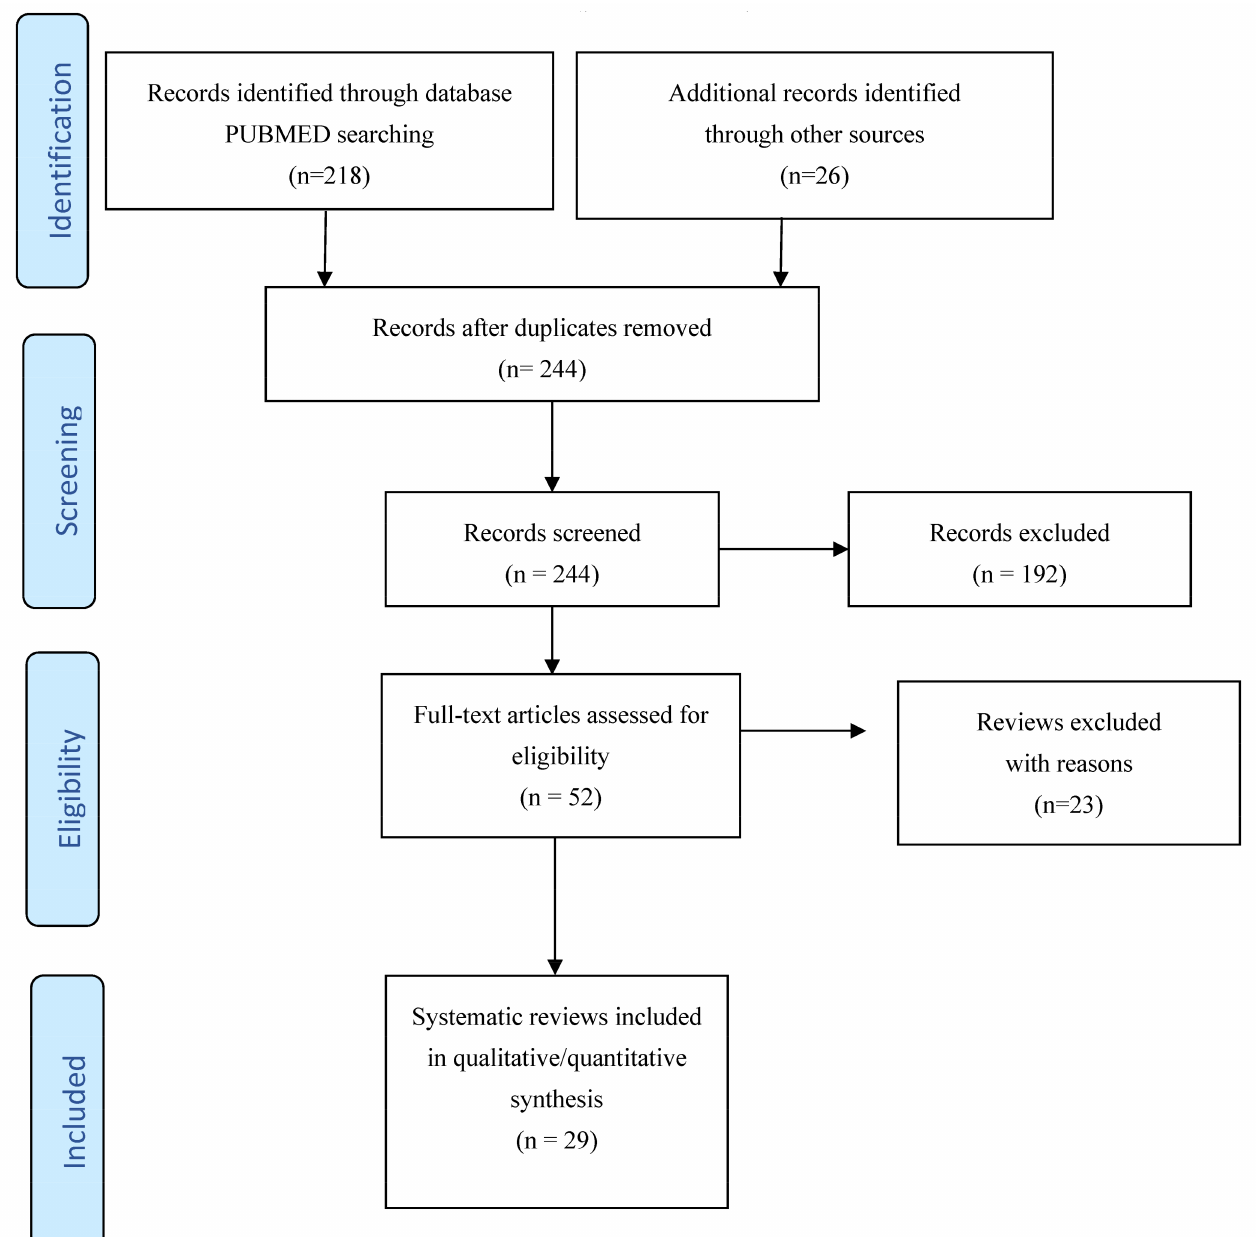
Figure 1. PRISMA flow diagram of study